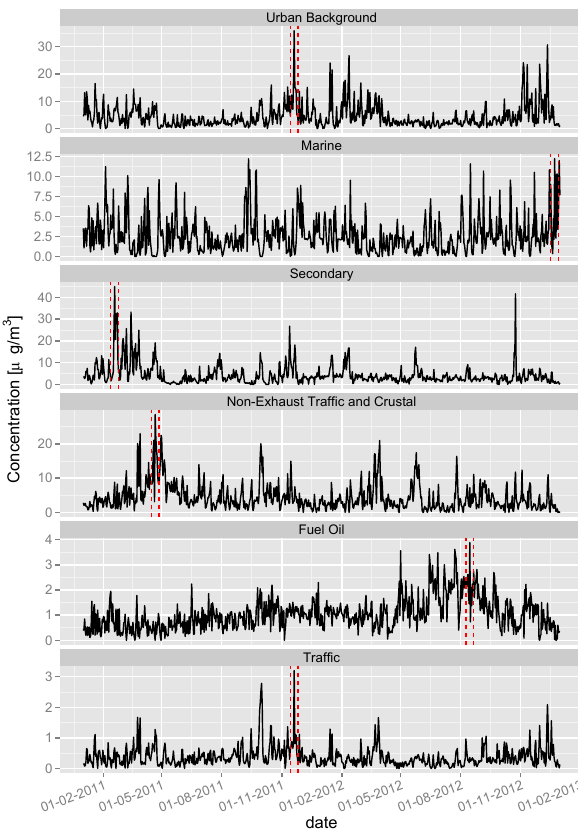
Figure 6. Daily factor scores outputted from PMF2 GF. Vertical red lines indicate when each factor has the highest contribution to PM 10 : 20 November 2011 – urban background; 23 December 2012 – marine; 18 February 2011 – secondary; 21 April 2011 – non- exhaust and crustal; 15 August 2012 – fuel oil; 20 November 2011 –